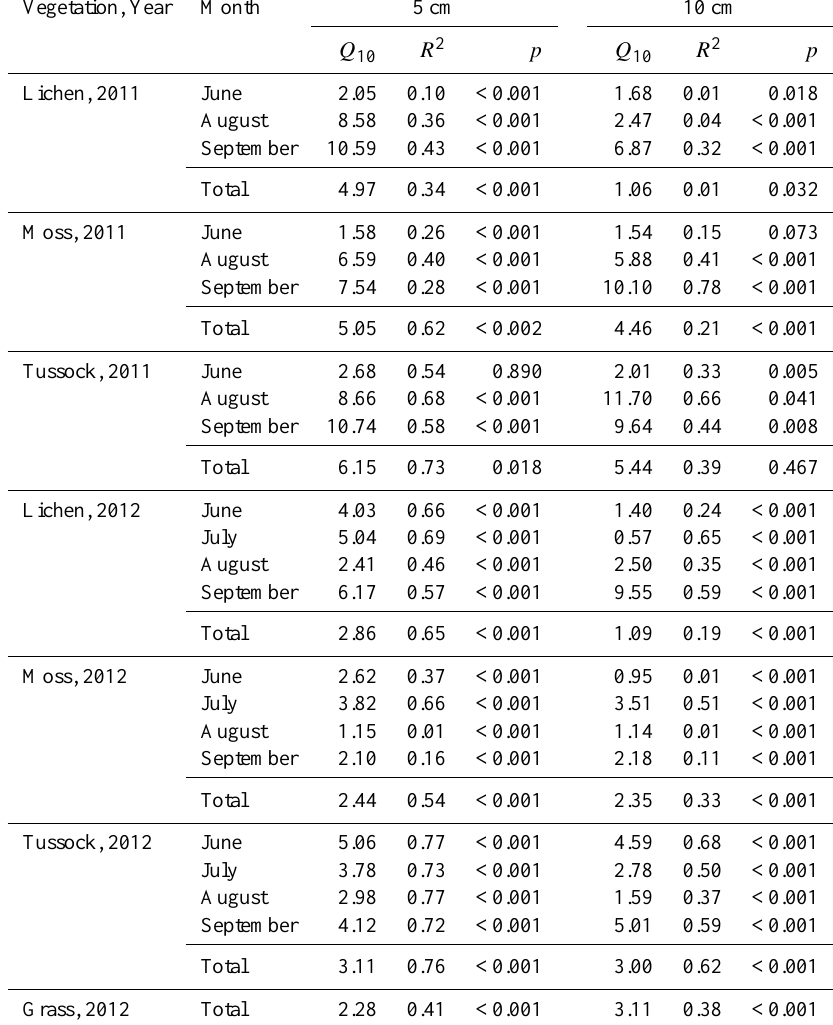
Table 2. Q 10 values and correlation coefficient between CO 2 efflux and soil temperature at 5 and 10cm below the soil surface in lichen, moss, and tussock during the growing season based on a one-way ANOVA with a 95% confidence level. Vegetation, Year